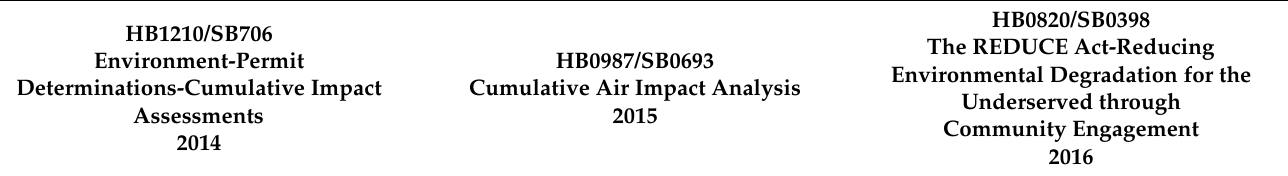
Table 1. Evolution of proposed cumulative impacts legislation in Maryland